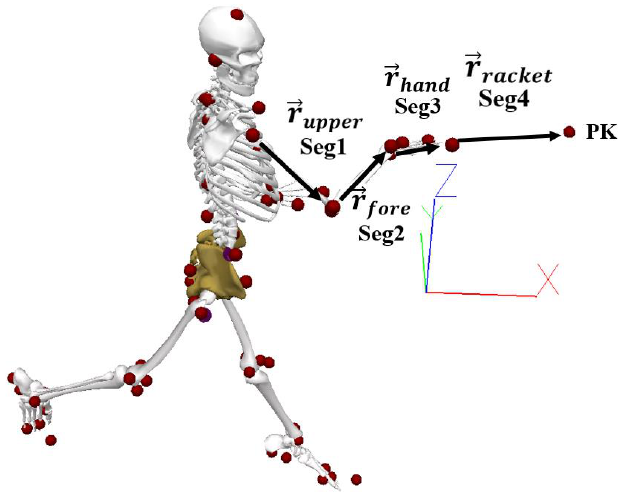
Figure 2. Participant’s virtual markers and derived vectors. Seg1 ( segment 1: upper arm), Seg 2 (seg- ment 2: forearm), Seg 3 (segment 3: hand), Seg 4 (segment 4: racket), Pk (centre of the